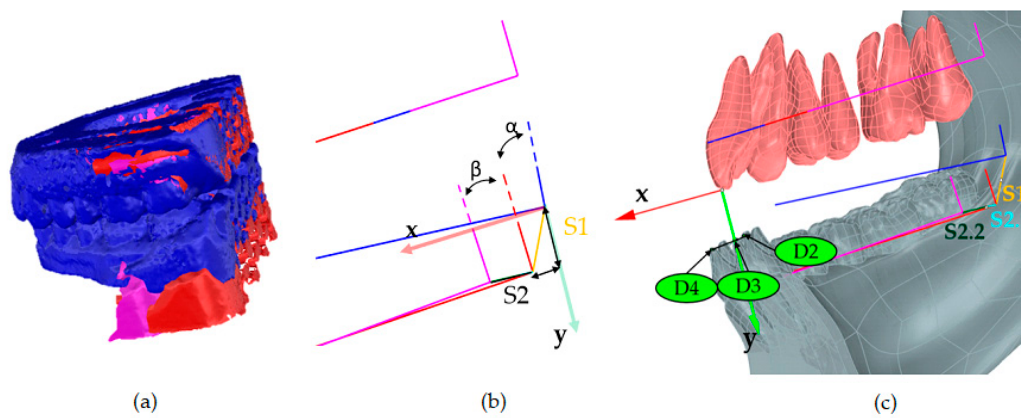
Figure 5. ( a ) Superimposition of the three scans of the dental casts at Rest (blue), Lift (red), Max advancement (magenta); ( b ) the construction reference frames (CRFs) overlapped in the upper arch provide the combined translation and rotation during Lift (S 1 ),) and up to Max advancement (S 2 ); ( c ) mandibular displacement due to the S 1 and S 2 roto translations and qualitative assessment of the Head-to-head configuration (S 2.1 ).